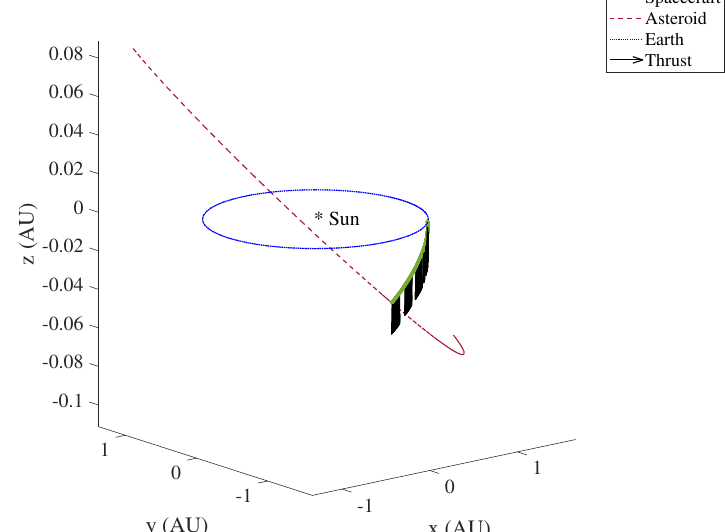
Figure 5. Orbit of the spacecraft, with the thrust vectors, from the earth to the asteroid for a very short trip. This option had a high value of ζ at launch, T = 52.98 days, m prop,used = 16.6 kg, and ∆ V = 7.46 imp